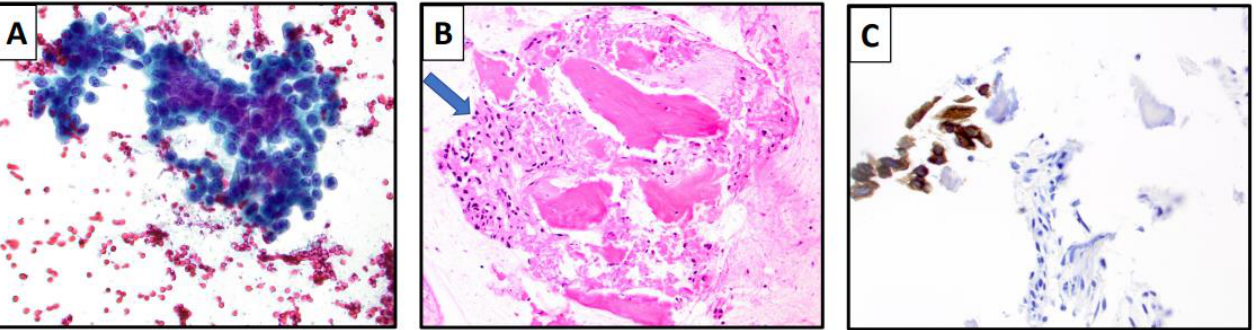
Figure 1. ( A – C ) Metastatic breast cancer in bone. ( A ) FNA smear shows clusters of loosely cohesive tumor cells with moderate pleomorphism and prominent nucleoli. ( B ) Cell block shows tumor cells (arrow) in association with bone fragments. ( C ) Tumor cells show positive staining with pancytokeratin consistent with metastatic carcinoma.